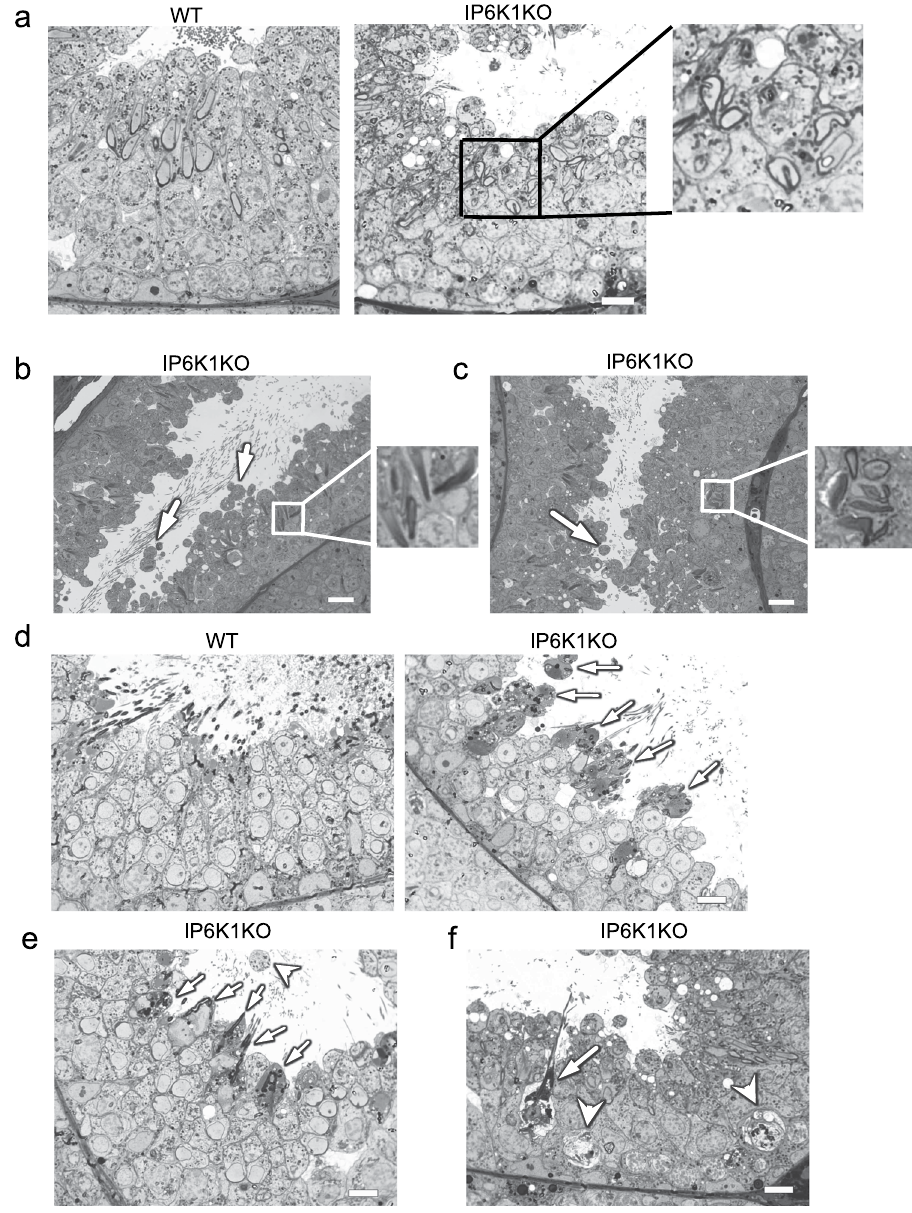
Figure 4. Spermiation failure and phagocytosis of sperm by Sertoli cells in IP6K1 KOs. ( a – f ) Toluidine blue staining of testes. ( a ) In stage X seminiferous tubules of IP6K1 KOs, the elongating spermatids were disoriented (inset). Scale bar 10 μ m. ( b ) In stage I seminiferous tubules of IP6K1 mutants, the elongated spermatids were disoriented (inset) and some round spermatids were sloughed off (arrows). Scale bar 20 μ m. ( c ) In stage II-III seminiferous tubules of IP6K1 KOs, the elongated spermatids were disoriented and malformed (inset), some round spermatids were dislodged (arrow). Scale bar 20 μ m. ( d ) In stage VII seminiferous tubules. Sperm cells were not released but engulfed by Sertoli cells in IP6K1 KOs (arrows). Scale bar 10 μ m. ( e ) In stage VIII seminiferous tubules of IP6K1 KOs, sperm cells were “eaten” by Sertoli cells (arrows). Sloughed off round spermatids were evident in the lumens (arrowhead). Scale bar 10 μ m. ( f ) In stage IX seminiferous tubules of IP6K1 mutants, “choking down” sperms killed Sertoli cells (arrow). Arrowheads point to phagosomes (digested spermatocytes) within Sertoli cells. Scale bar 10 μ